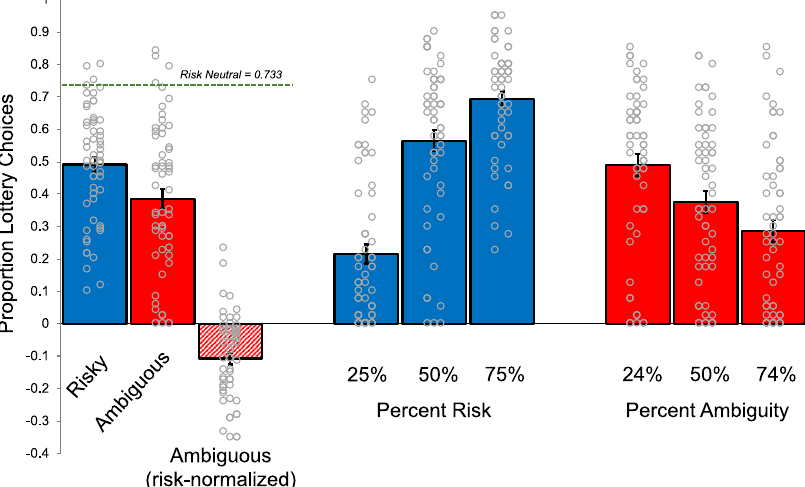
Fig. 2 Lottery Choice Results (Study 1). Participants ( n = 58) demonstrated risk (left, blue) and ambiguity aversion (left, red), even when accounting for risk (left, red/white diagonal). Further, participants chose the lottery option more as the probability of winning increased (blue, right) and less as the proportion of ambiguity increased (red, right). Overall, ambiguity was perceived as more aversive than risk. Errors bars indicate SE.